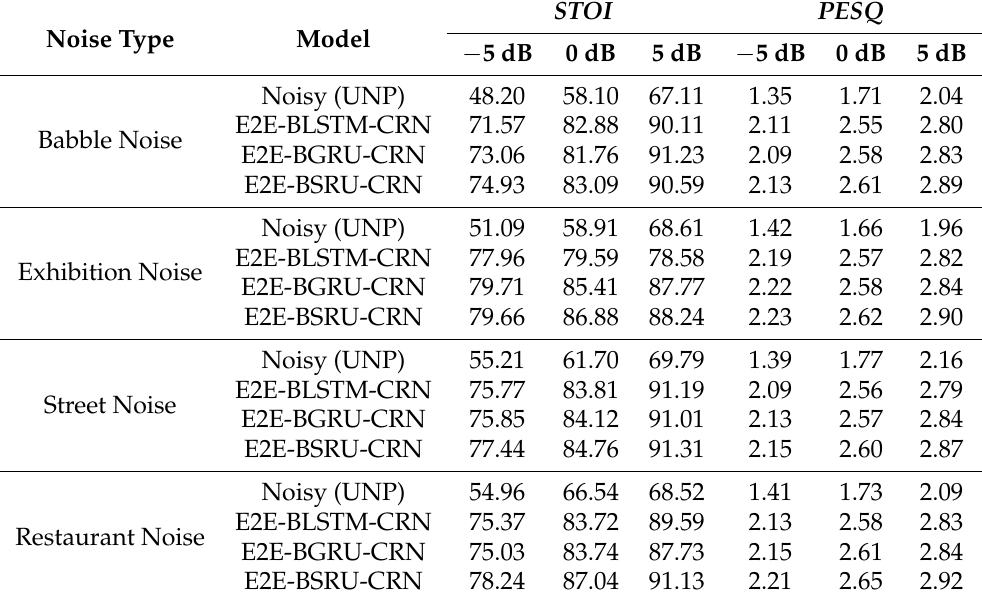
Table 2. STOI and PESQ scores in example Seen